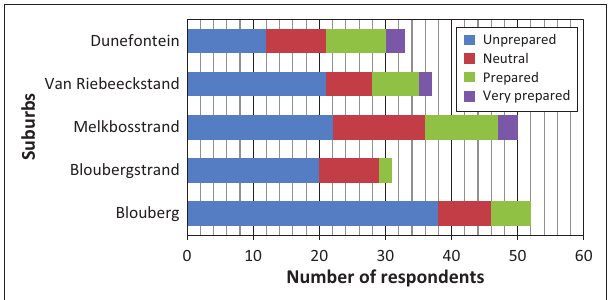
FIGURE 9: Respondents self-rating their perceived level of preparedness for a general emergency.